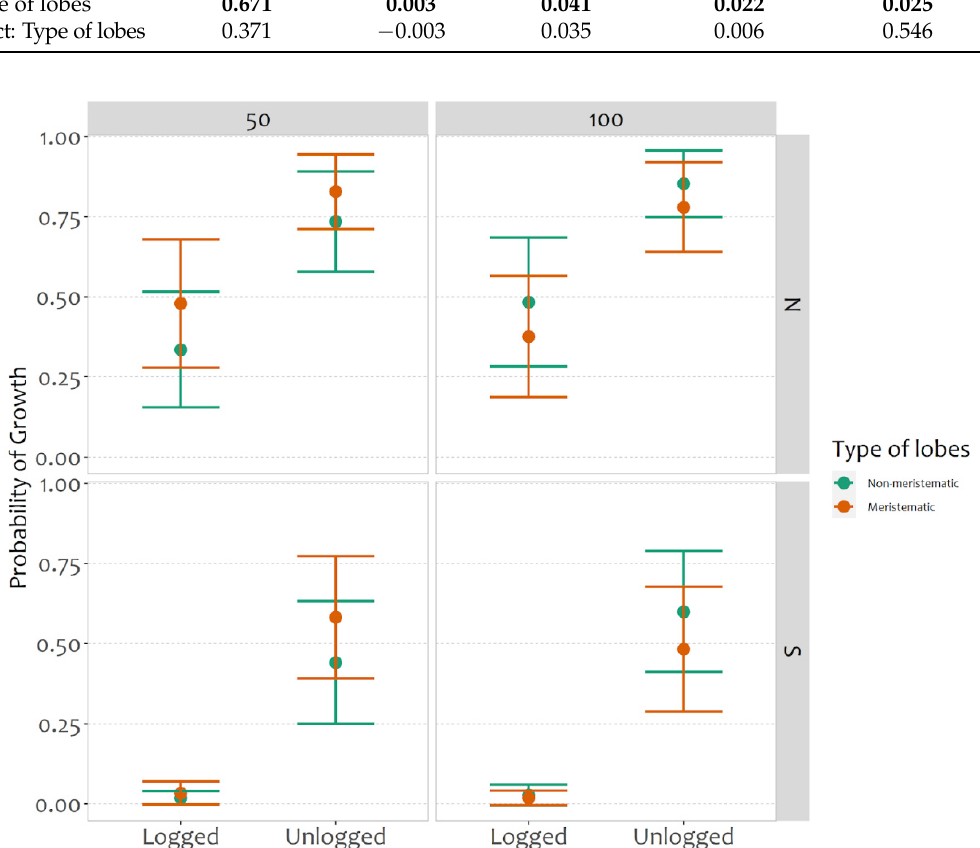
Figure 1. Predicted probability of growth for forest types (logged and unlogged), type of lobes (non-meristematic and meristematic), aspect (N = north, S = south) and different heights from the ground (50 and 100 cm). Table 1. Full averaging of generalized linear mixed model coefficients among models showing a delta AICc < 2. Significant interactions are in bold. Variables with sum >0.65 and with a significant Wald test are shown in bold.